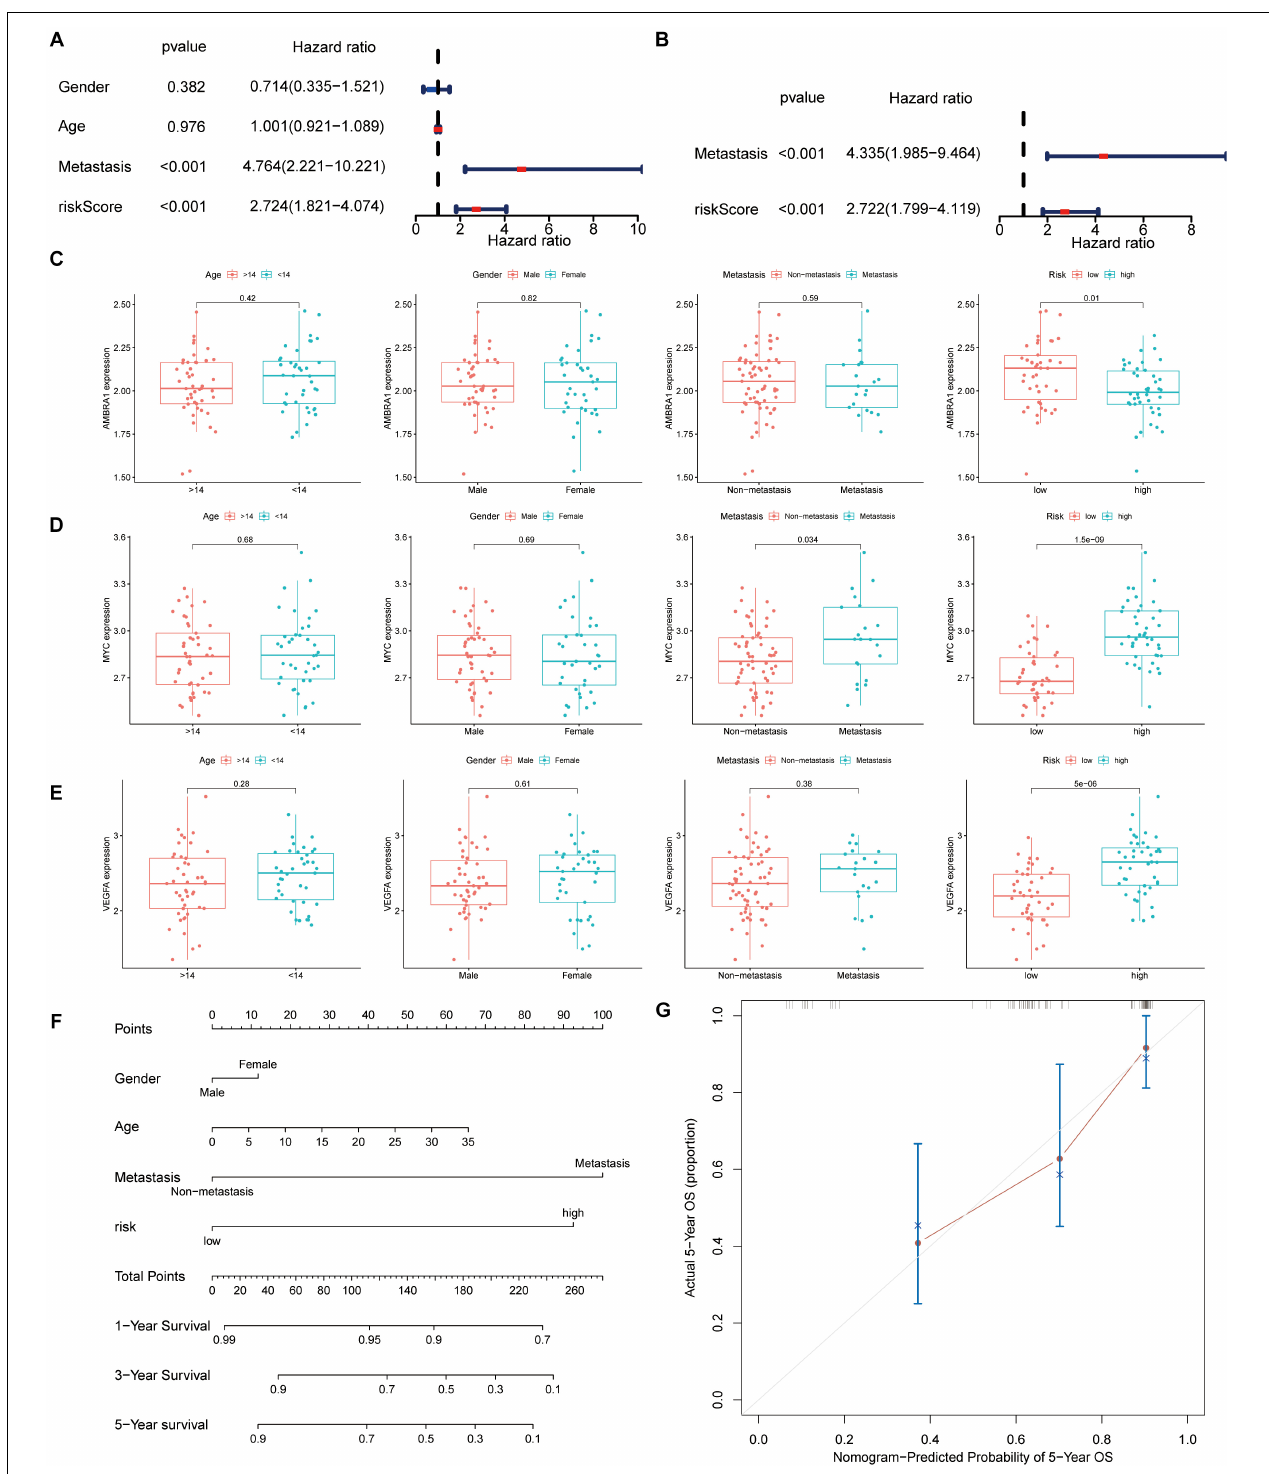
FIGURE 7 | Autophagy-associated gene signature was significantly related to survival in osteosarcoma and clinical correlation analyses. (A,B) Univariate and multivariate cox analysis showed the autophagy-related genes signature and metastasis were two independent predictor of prognosis in osteosarcoma. (C–E) The expression of the three key genes, the patients from the TARGET database were grouped according to age ( < 14 y; ≥ 14 y), gender, metastasis, and riskscore. The X -axis represents the different groups and the Y -axis represents their gene expression levels (FPKM). (F) Nomogram based on gender, age, metastasis, and risk in the TARGET database. (G) Calibration plots of the nomogram for predicting the probability of OS at 5 years.